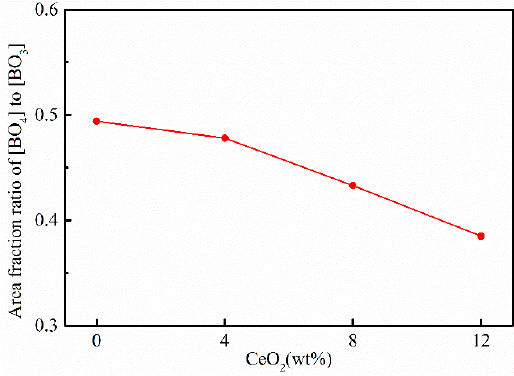
Figure 10. The area ratio of [BO 4 ] to [BO 3 ] in the mold fluxes with different CeO 2 contents.